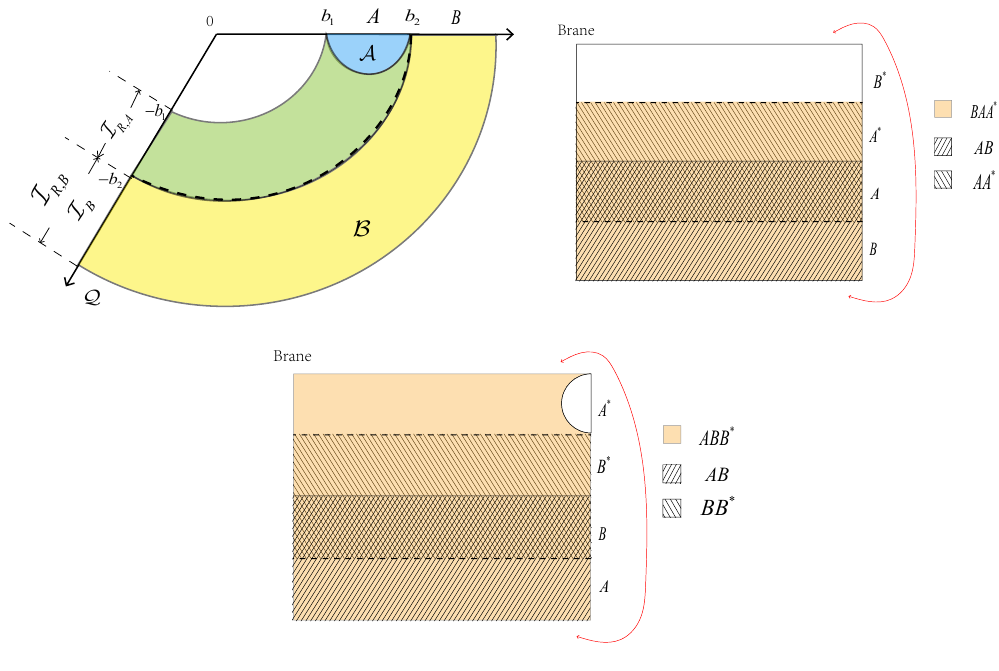
Figure 10 . Phase-A2. The region A admits no entanglement island but a reflected island. The entanglement wedges satisfy W( AA ∗ B ) = W( AA ∗ ) ∪ W( AB ) , but W( ABB ∗ ) ⊃ W( AB ) ∪ W( BB ∗ )